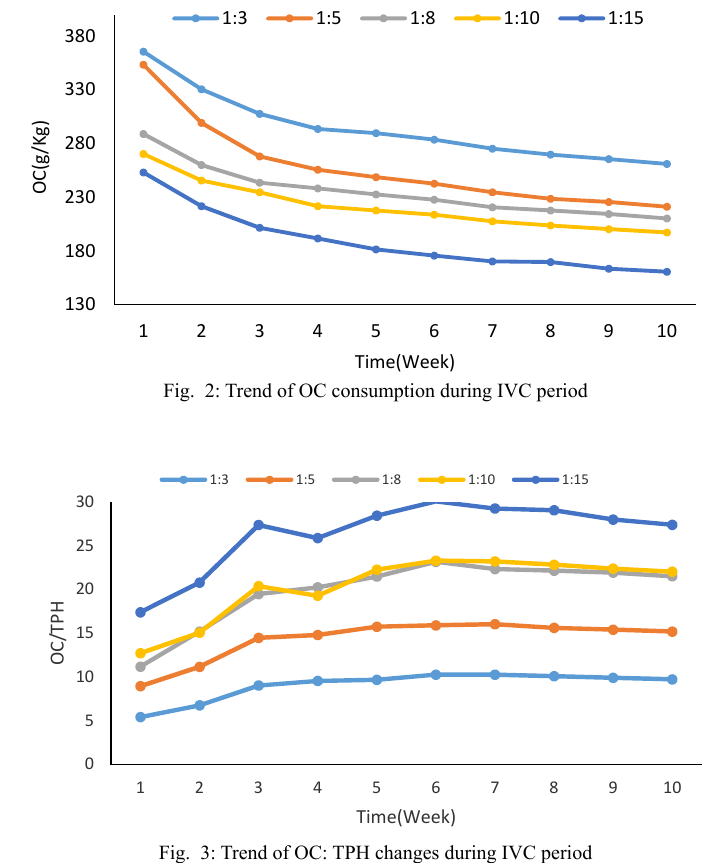
Fig. 3: Trend of OC: TPH changes during IVC period